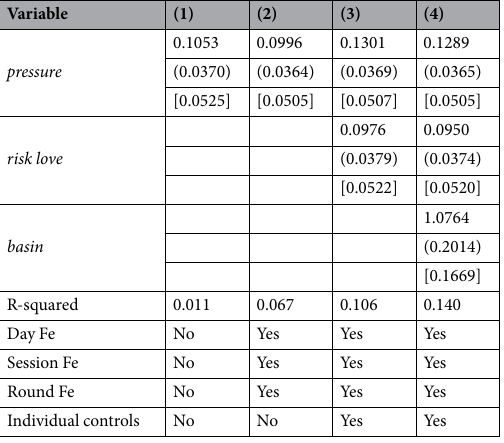
Table 1. Main results - OLS Regressions. The number of observations is 711. The dependent variable is stag it = 1 if individual i chose stag in round t and = 0 otherwise. Individual controls include: gender, post-graduate education, father’s education, mother’s education, CRT scores, REI40 measures, inexperience in game theory and lab experiments, measure of trust in others (see Section B.3 of the SI Appendix for variables’ definitions). Standard errors in round brackets are heteroskedasticity robust, while those in square brackets are clustered at the individual